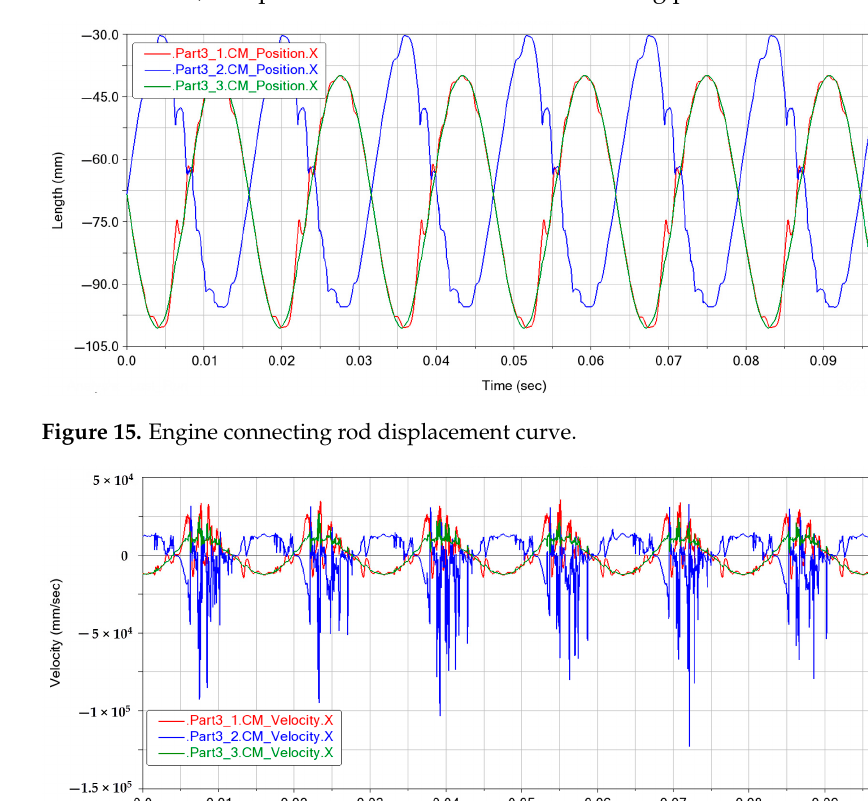
14 of 25 Figure 13. Engine piston speed curve.